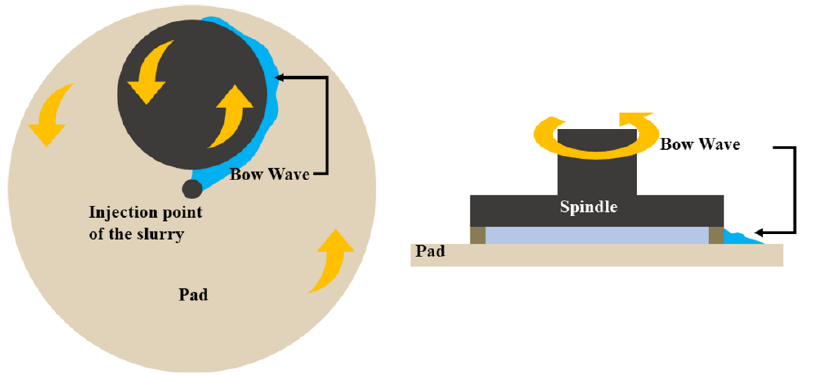
Figure 13. Schematic of the bow wave phenomenon.